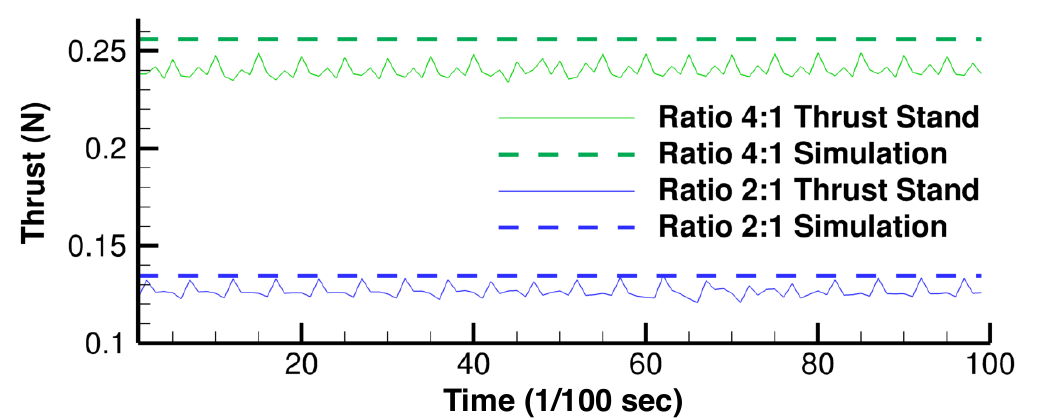
Figure 21. Thrust as a function of time for two different oxidizer:fuel